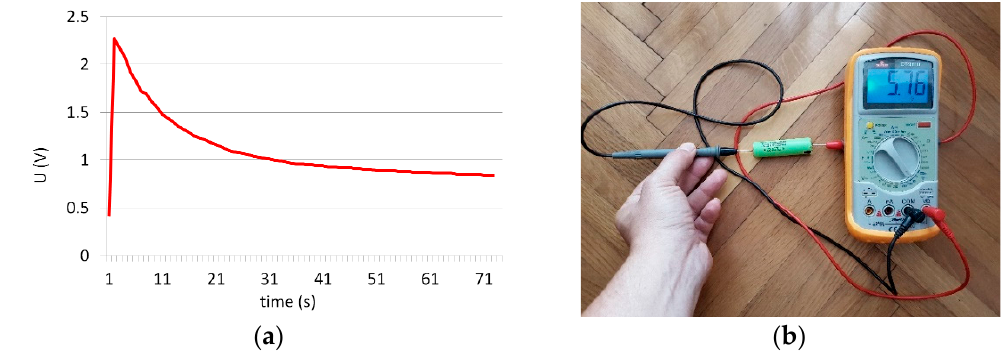
Figure 14. Cell No. 1 high impedance load discharge graph ( a ) and overcharged cell No. 3, temper- ature and structurally stable ( b ).